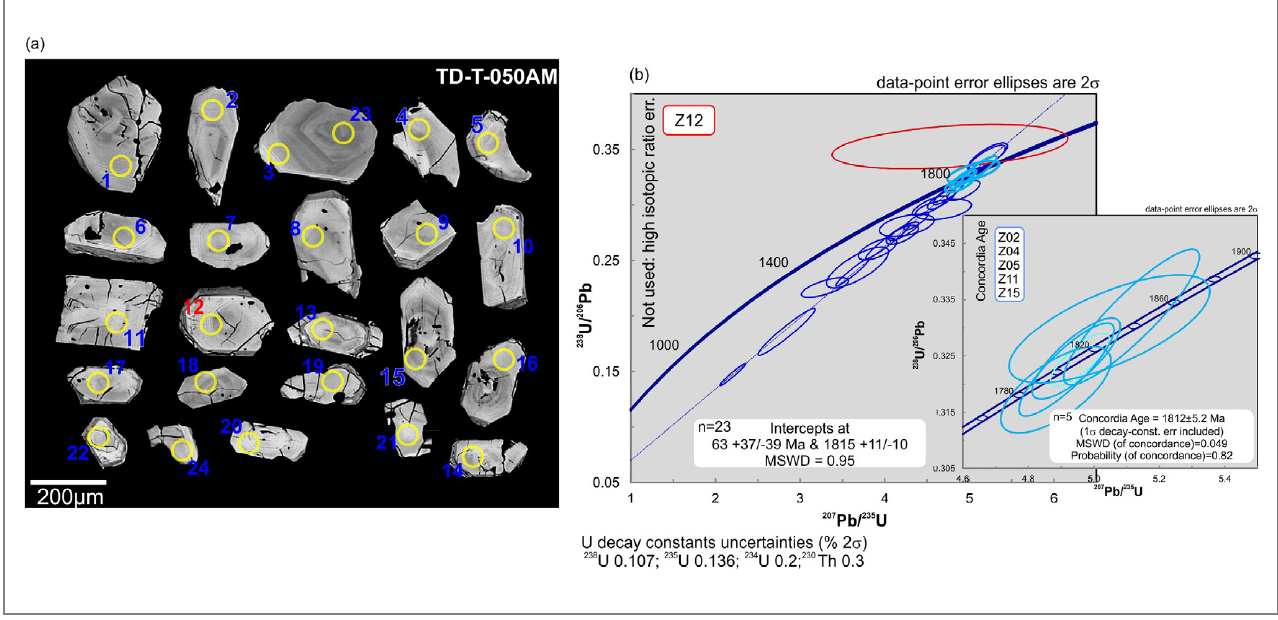
FIGURE 11 - (a) BSE image of zircons of a porphyritic granite from the Paranaíta Intrusive Suite (sample GR-001A) showing their morphological features, location and ID of pits; (b) U-Pb concordia diagram for GR-001A.